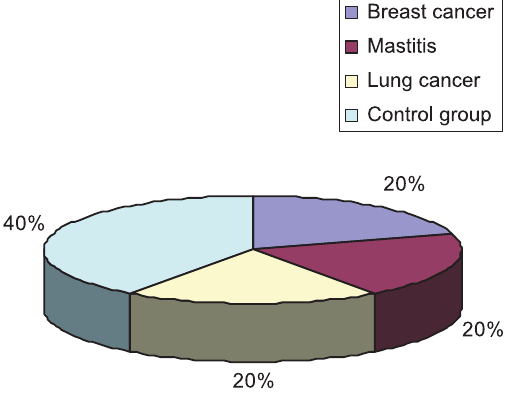
FIGURE 1. The patient diagnosis involved in the